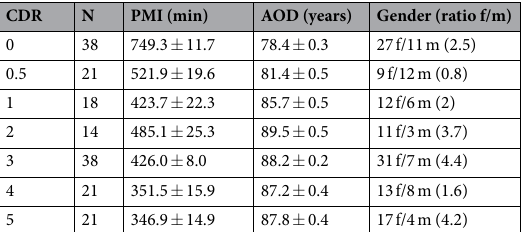
Table 1. Characteristics of the subjects from the Mount Sinaï Hospital cohort stratified by CDR scores (mean ± sem). Abbreviations in Table: CDR: clinical dementia rating; N, size of the sample; PMI(min): post- mortem interval in minutes; AOD: age of death; f/m: females/males. One hundred seventy-one brain samples out of the 182 individuals were used and are presented above.